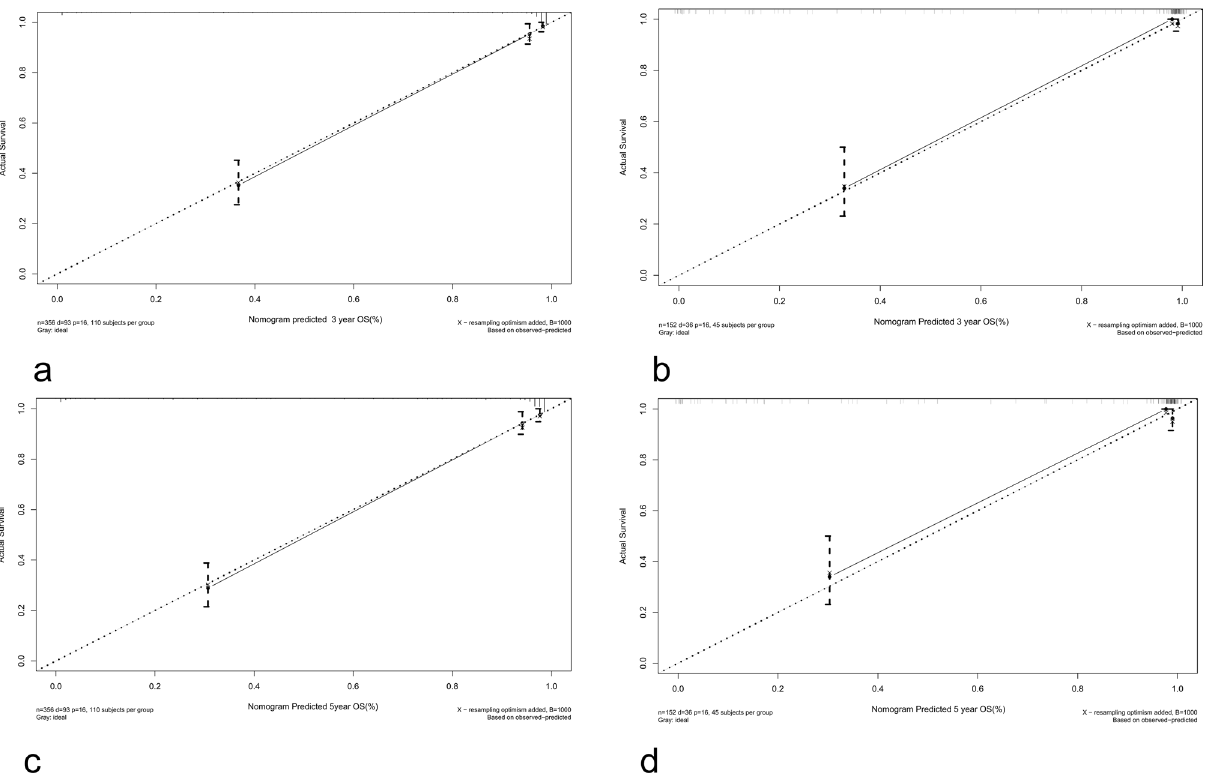
Figure 5. Internal calibration plots of 3-year overall survival rates in training group ( a ) and validation group ( b ) Internal calibration plots of 5-year overall survival rates in training group ( c ) and validation group ( d